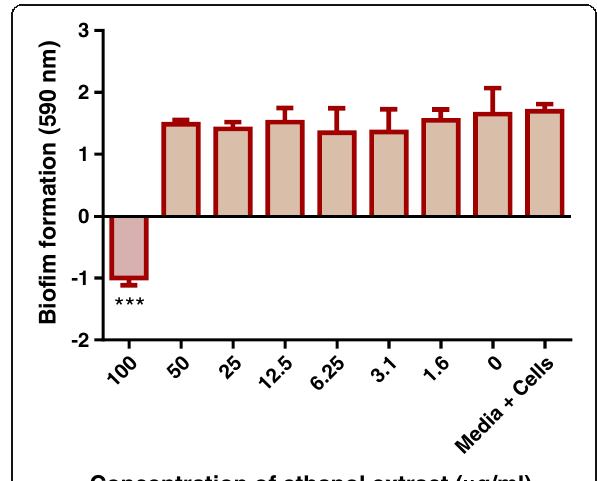
Fig. 6 The effect of the different concentrations of the ethanol extract on M. smegmatis biofilm formation. M. smegmatis was incubated in different concentrations of the ethanol extract of P. curatellifolia leaf powder for 72 h at 37 ̊ C. The biofilm mass that formed during the incubation period was stained using crystal violet staining which was quantified spectrophotometrically at 590 nm. The error bars indicates the standard deviation from mean ( n = 4). Dunnet ’ s multiple comparison test was used to compare columns using graph pad prism 5 software. The asterisks (*) indicate statistical significant differences with the growth control (media + cells) * < 0.05 *** <